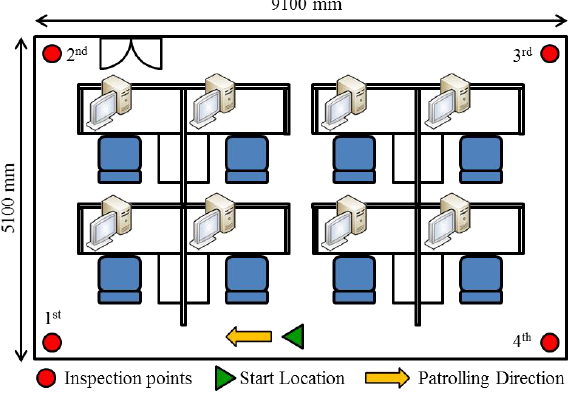
Figure 9. Environment used in patrol